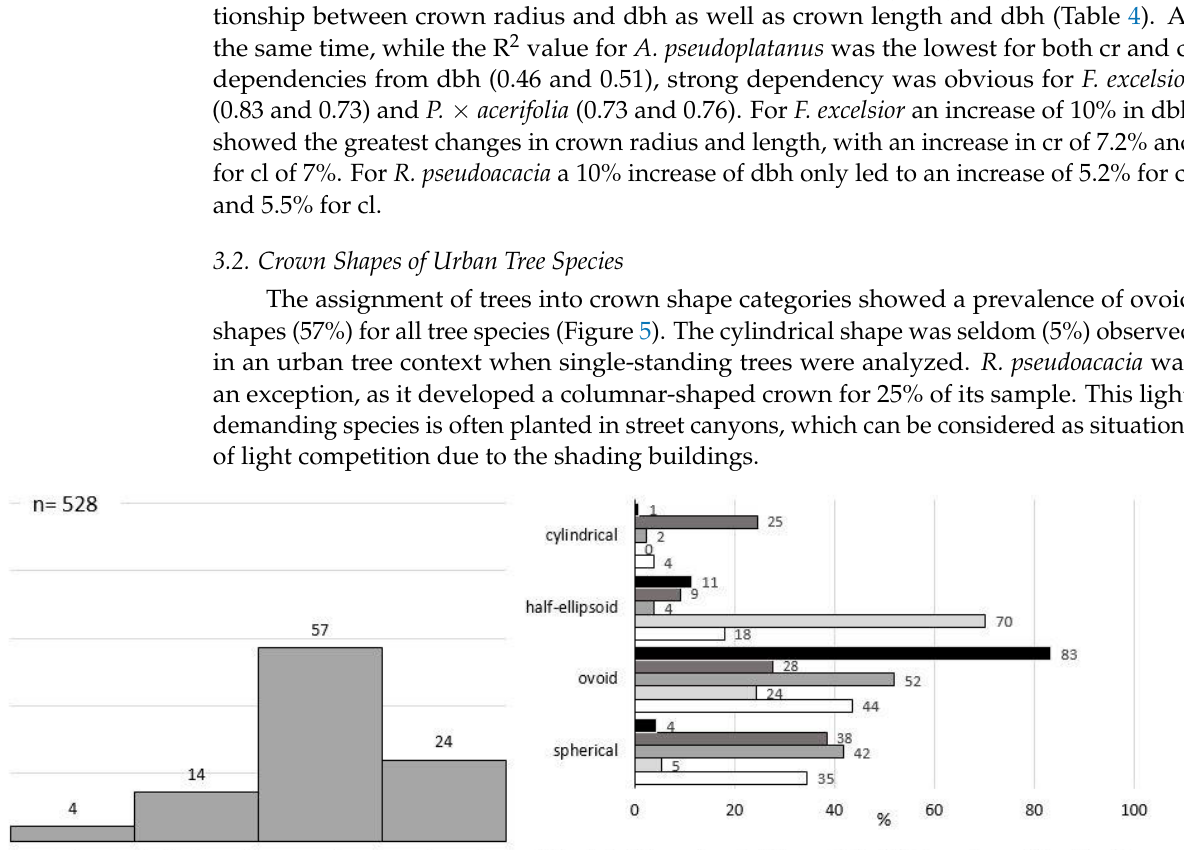
Figure 4. Crown length and diameter at breast height relationship for seven common urban tree species. Table 4. Results of the transformed double-logarithmic equation detecting significance of changes in crown radius and crown length related to changes in dbh.